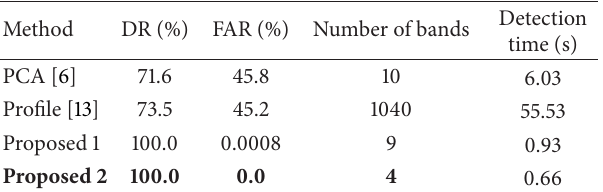
Table 2: Comparison of abnormal region detection methods for the leaf database (DR: detection rate, FAR: false alarm rate, Proposed 1: spectral analysis, Proposed 2: spectral + spatial analysis).